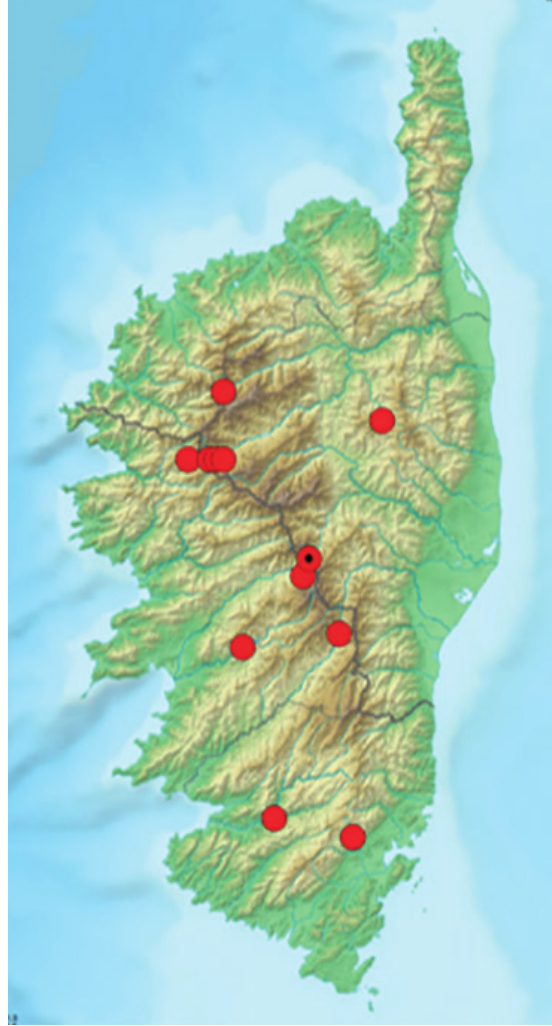
Fig. 10. Distribution of Dicranopalpus insignipalpis (Simon, 1879) on Corsica. The black spot indicates the provenance of the specimens used in the redescription